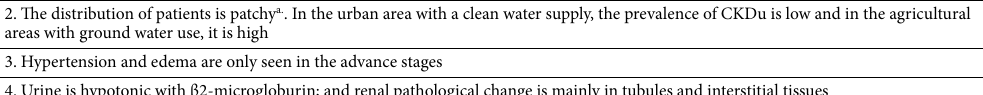
Table 1. Clinical features of CKDu in Sri Lanka. a For example, in a village, 2–3% of population no less than 18 years old are affected by CKDu, but in the neighboring village only a few kilometers away, no patients are found.